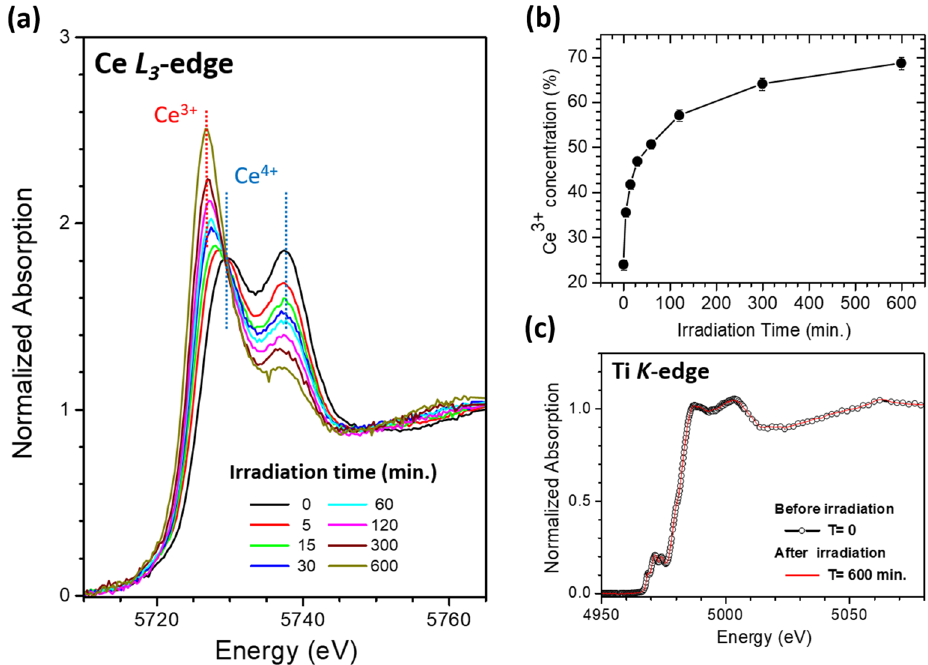
Figure 2. ( a ) Ce L 3 -edge XANES of UV-light irradiated sample with various irradiation times. ( b ) Plot of Ce 3+ concentration vs. irradiation time. ( c ) Ti K-edge XANES of sample before and after 600 min of UV-light irradiation.